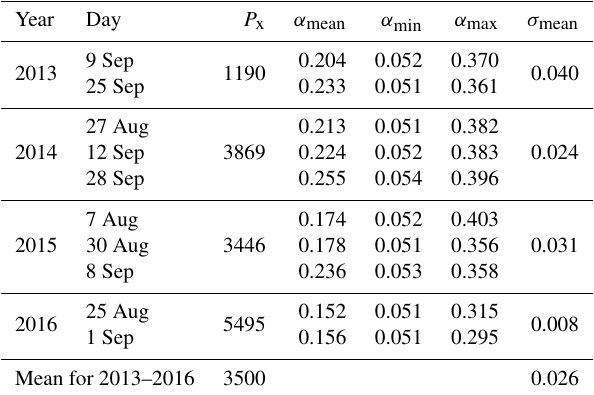
Table 3. Overview of scenes used in the snapshot uncertainty anal- ysis. P x refers to the number of pixels that were used to derive un- certainty. Mean ( α mean ), minimum ( α min ) and maximum ( α max ) albedo, as well as the mean ( σ mean ) standard deviation of point- based bare-ice albedo for each individual scene set from each year are